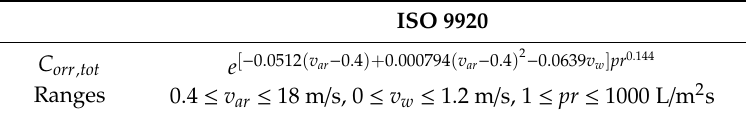
Table 2. Calculation of C orr,tot coe ffi cient of specialized, insulating, cold weather clothing (SC) according to ISO 9920. Air permeability of clothing: pr.